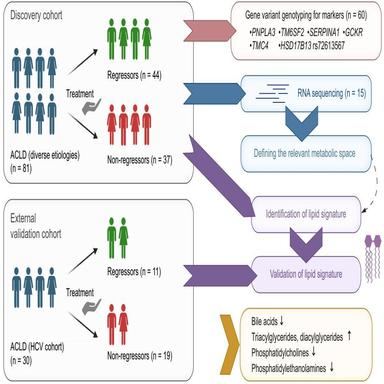
Schematic overview of the study design. (This figure appears in color on the web.)